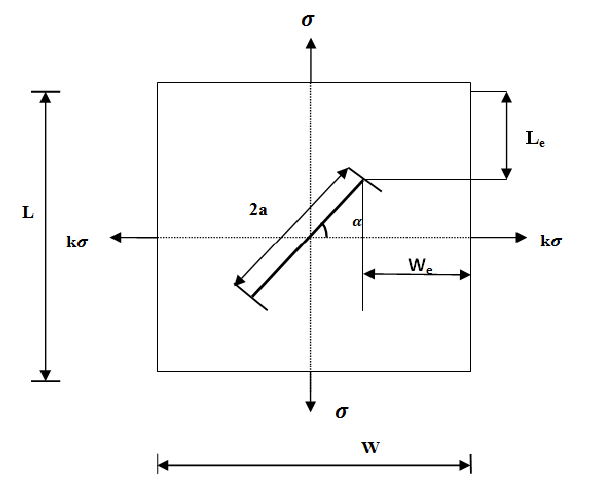
Figure 7: Effective length and effective width in the